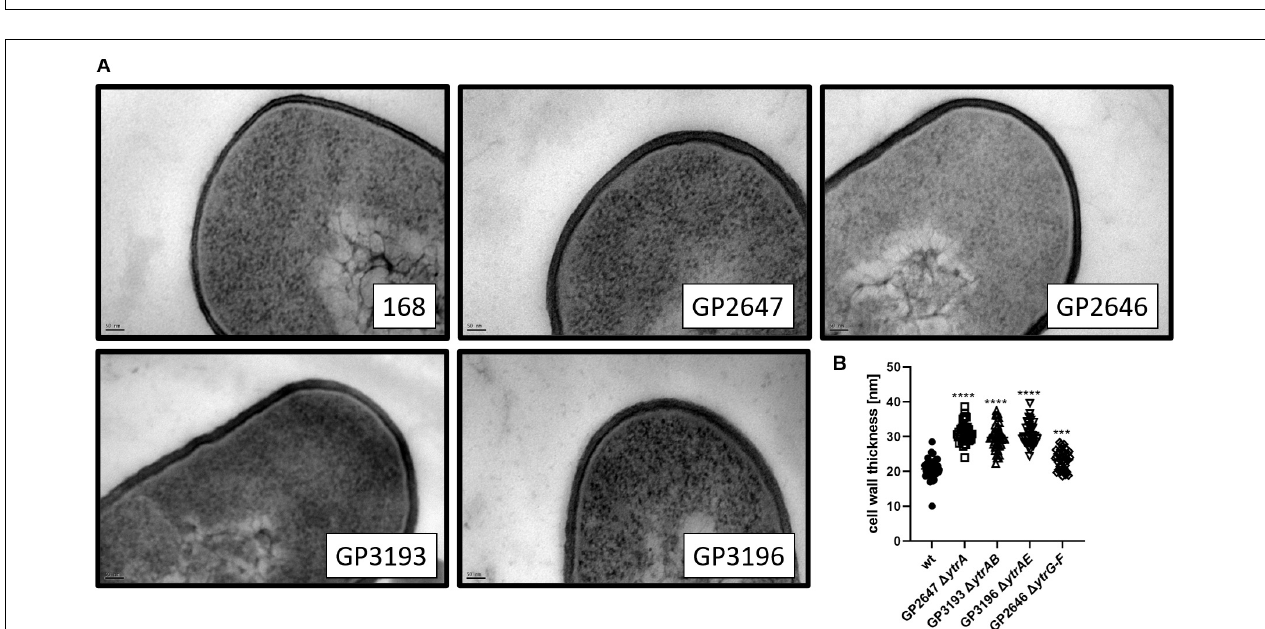
FIGURE 3 | Biofilm formation is affected by ytrA deletion. Biofilm formation was examined in the wild type strain DK1042 and respective deletion mutants of ymdB (GP2559), ytrA (GP3212), and ytrGABCDEF (GP3207). The biofilm assay was performed on MSgg agar plates as described in section “Materials and Methods.” The plates were incubated for 3 days at 30 ◦ C. All images were taken at the same magnification.